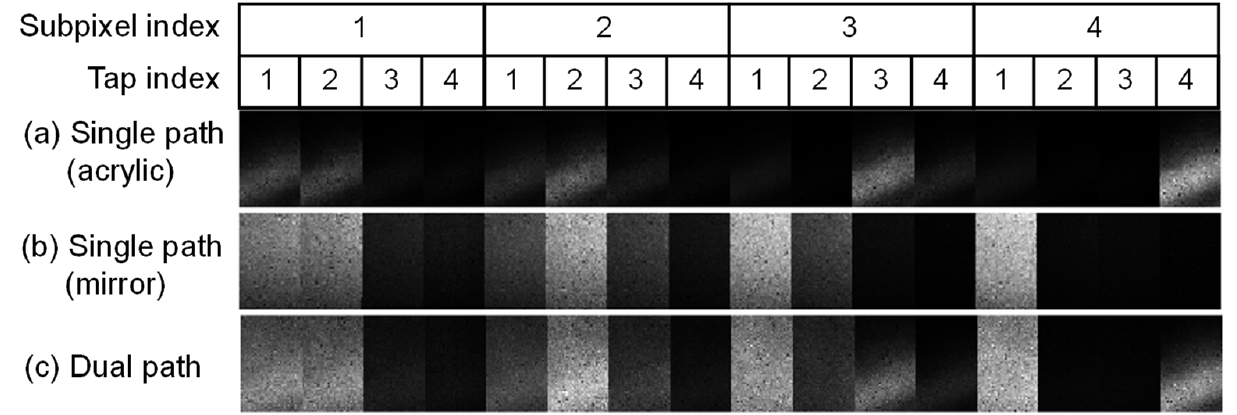
Figure 13. Captured images in the dual-path situation for the objective mirror and the acrylic plate placed at 9.3 m and 1 m, respectively. One hundred images are averaged.